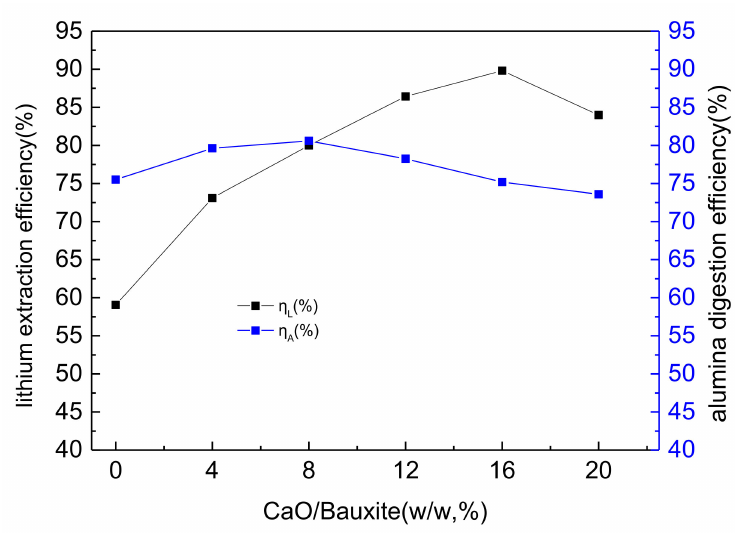
Figure 2. Effect of lime addition on lithium digestion behavior of bauxite (conditions: ρ (K 2 O) = 254 g/L, T = 265 ◦ C, t = 1